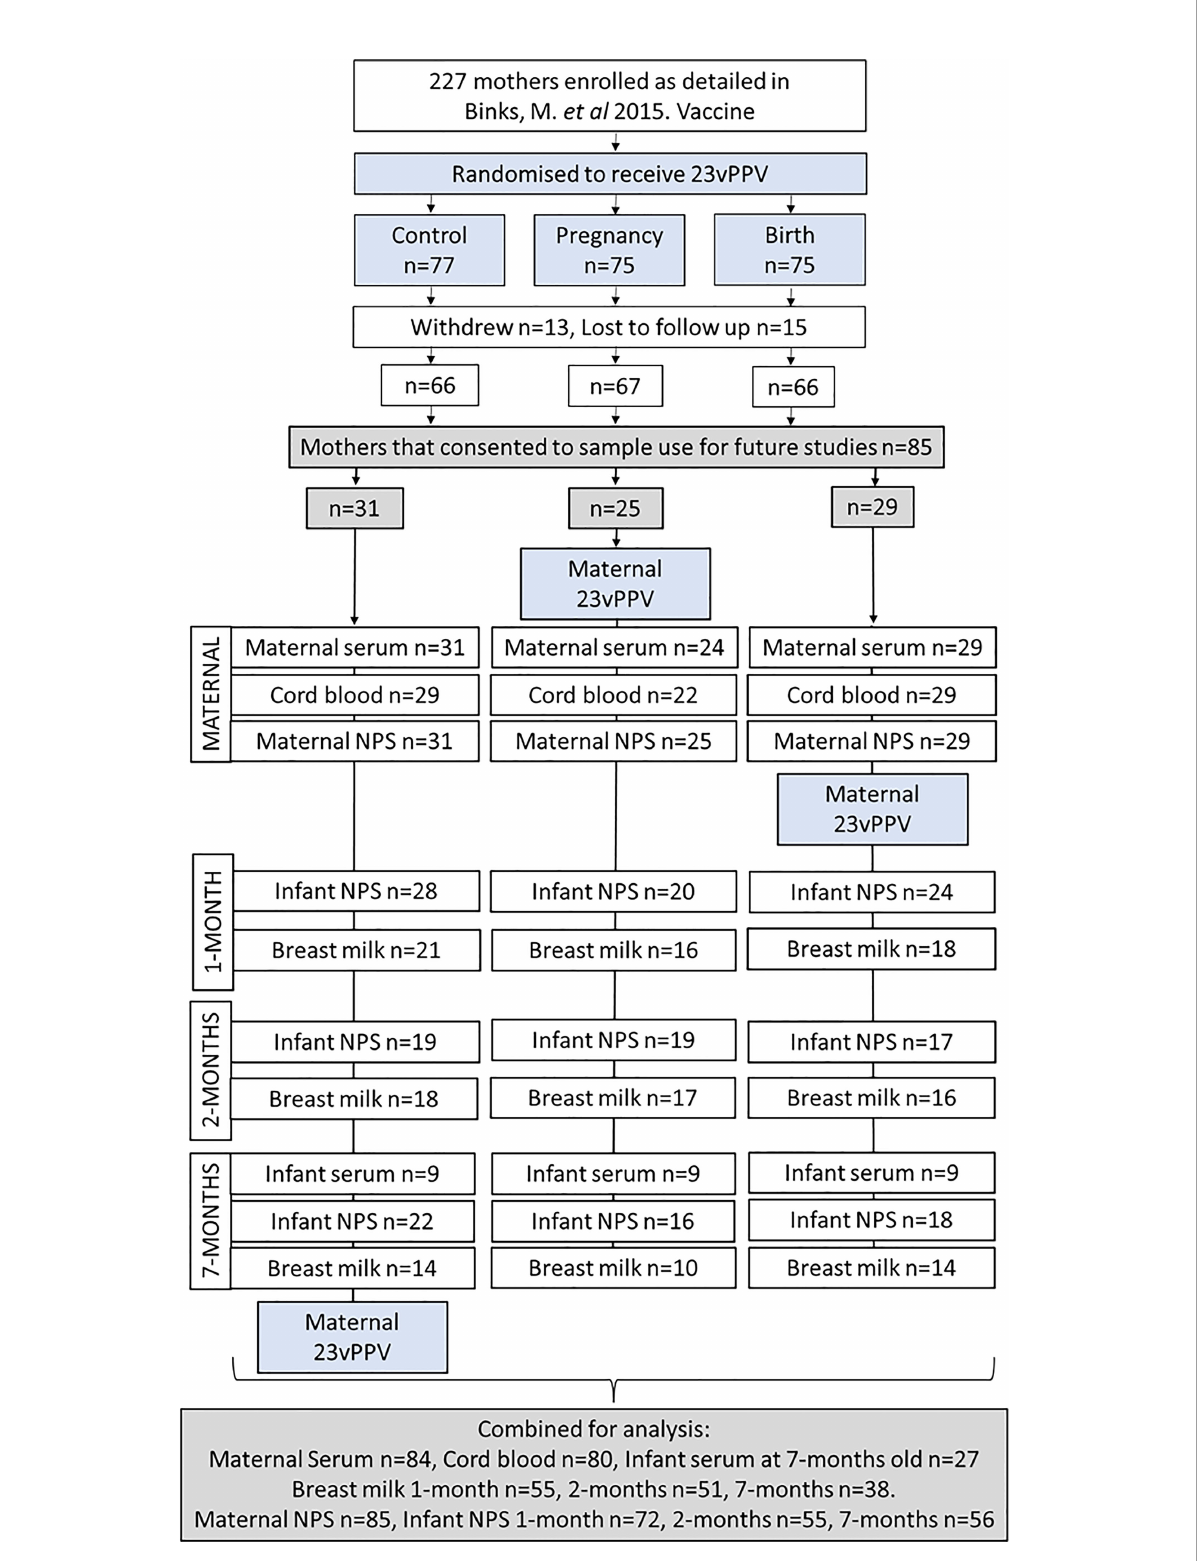
FIGURE 1 Participant fl ow chart and sample numbers. Of the 85 mother:infant pairs in this study 1 maternal serum sample was not collected (n=84); 5 mothers had no cord blood sera collected (n=80), and infant sera was not collected from 58 of the 85 infants